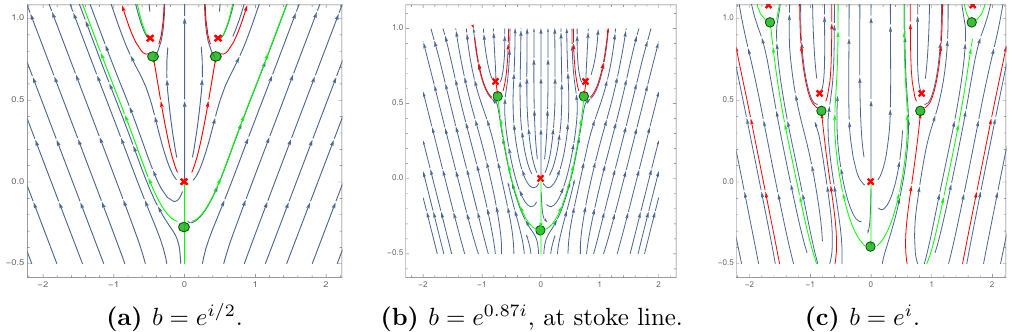
Figure 6. Morse (cid:13)ow for the theory with one chiral and one anti-chiral for b = e i= 2 , b = e 0 : 87 i and b = e i all with (cid:24) = 1. The green circles are saddles and the red crosses are poles. As (cid:18) increases the position of the saddles and the J and K cycles change. Figure (b) shows when the Stokes crossing happens. At this point the J cycle from the perturbative saddle connects with the K cycle from the vortex and anti-vortex. As (cid:18) increases beyond this value, (cid:12)gure (c), the K cycles from vortex/ anti-vortex no longer (cid:13)ow to the perturbative pole, but crosses through the real